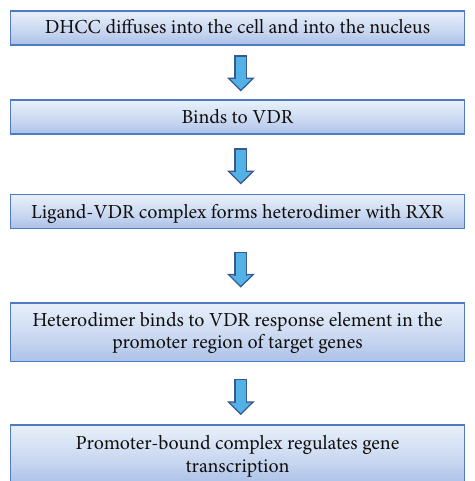
Figure2:SchematicactivityofDHCCintargetcellstoregulategene